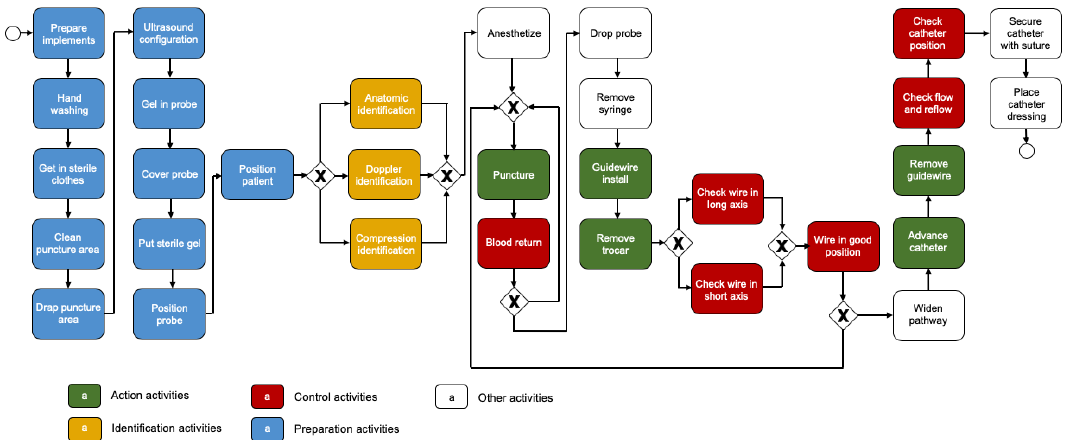
Figure 1. BPMN model of the UGIJCVC placement, enriched with the taxonomy